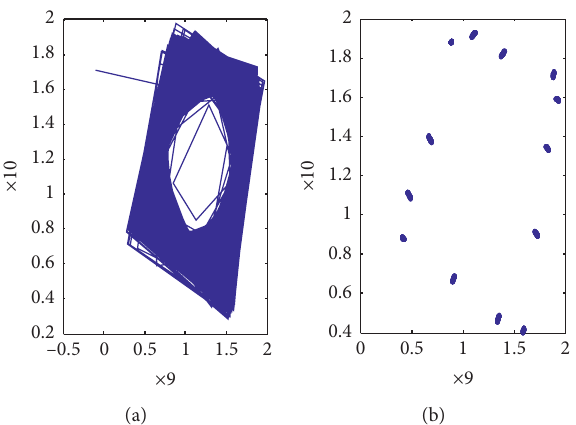
Figure 37: ω � 230 and k � 0 with the smoothed Coulomb model when t ∈ 0 . 05 0 . 0597 􏼂 􏼃 w